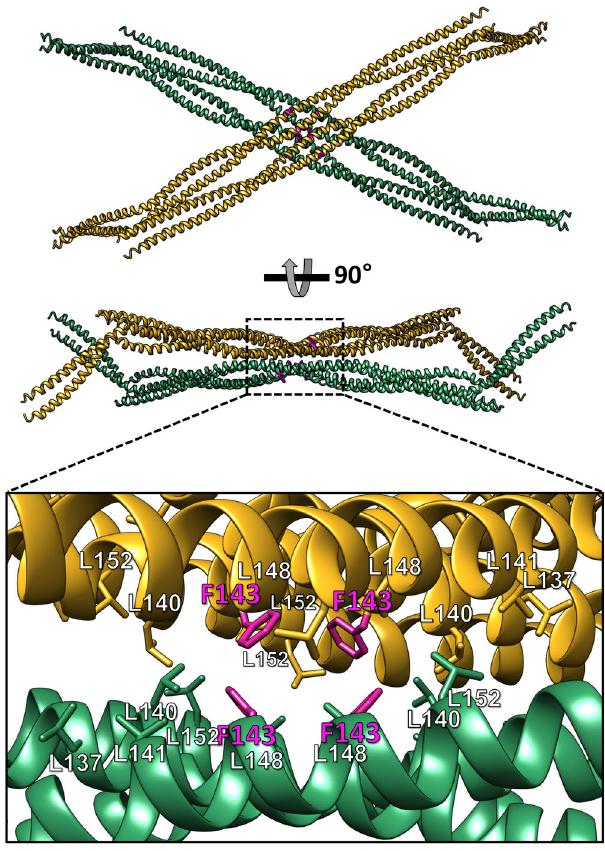
Fig. 4 The X-shaped interaction between the two A11 tetramers of the S143F mutant lamin fragment in the crystals. The top and side views of the X-shaped interaction between the two A11 tetramers were generated by crystal packing interactions. The Phe143 residues are presented in the magenta stick representations. The hydrophobic residues on the contact region for the X-shaped interaction between the two tetramers are shown in stick representations in the bottom